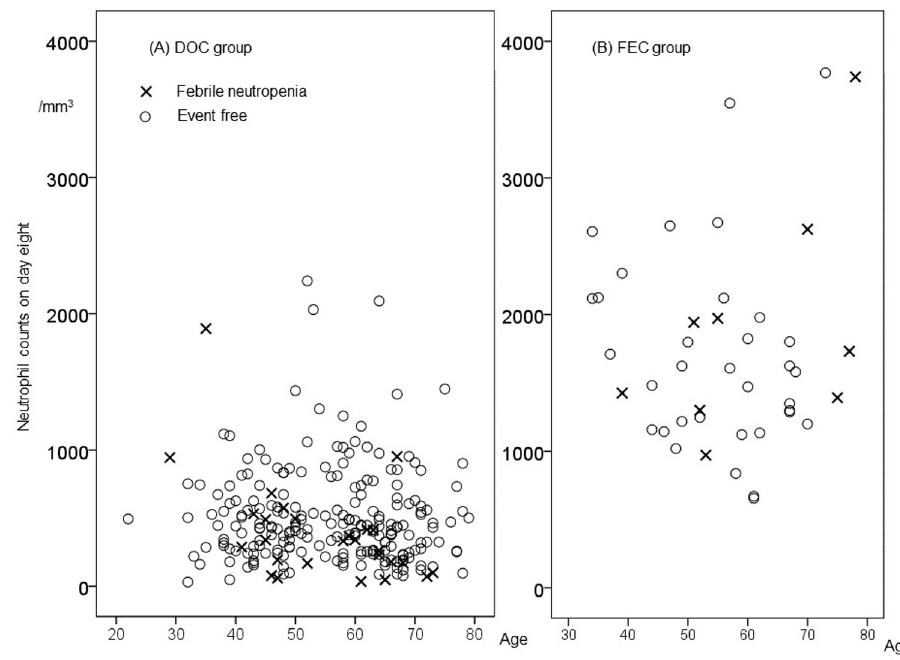
Fig 3. Febrile neutropenia and neutrophil counts on day 8 versus age. (A) in DOC group and (B) in FEC group, a scatter plot of age versus neutrophil count on day 8 is shown, patients experienced FN during a planned cycle were shown in punctuation mark (x) and who did not open circle